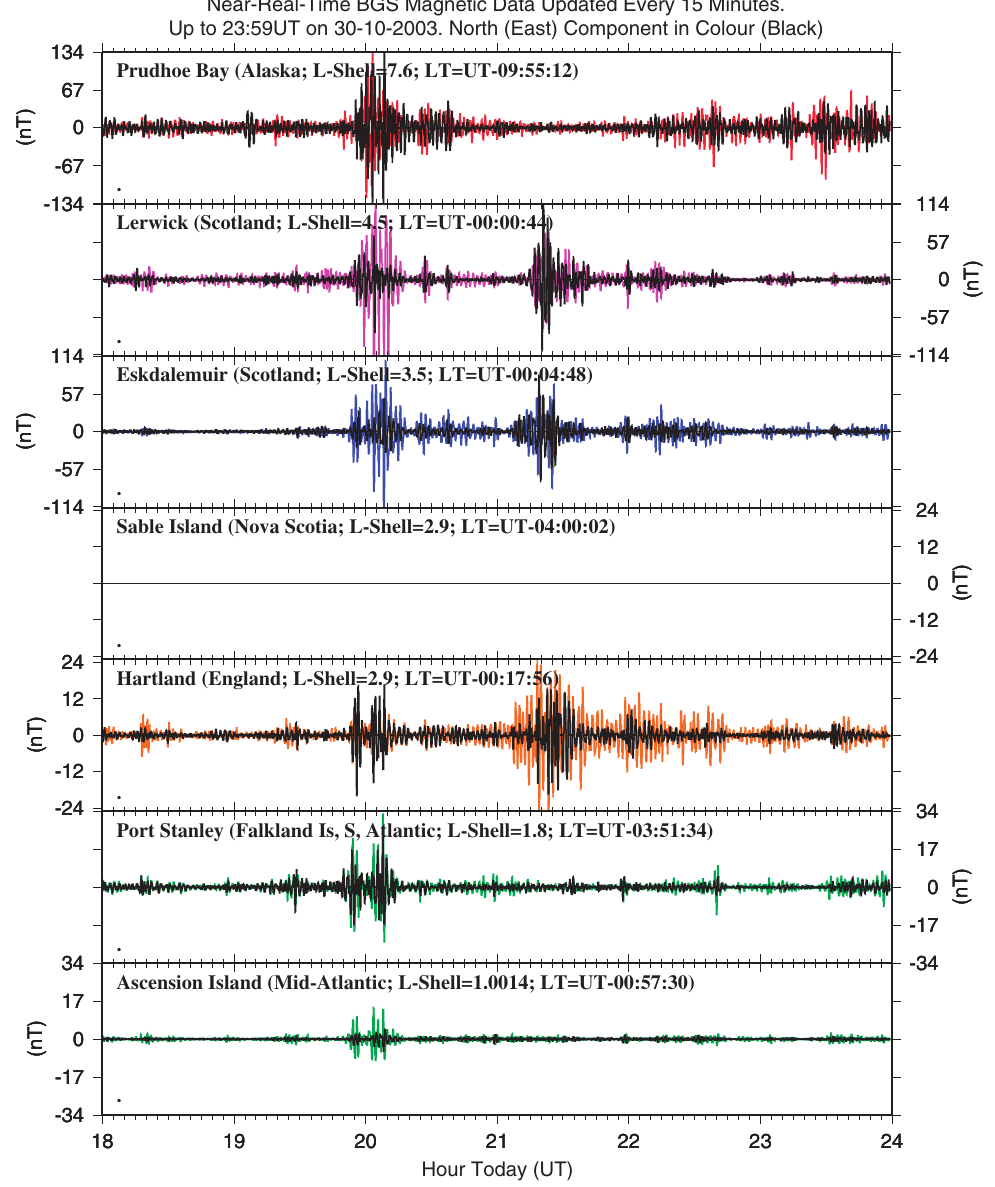
Fig. 10. Similar to fig. 9 but output from the Pi2 waveband (40-150